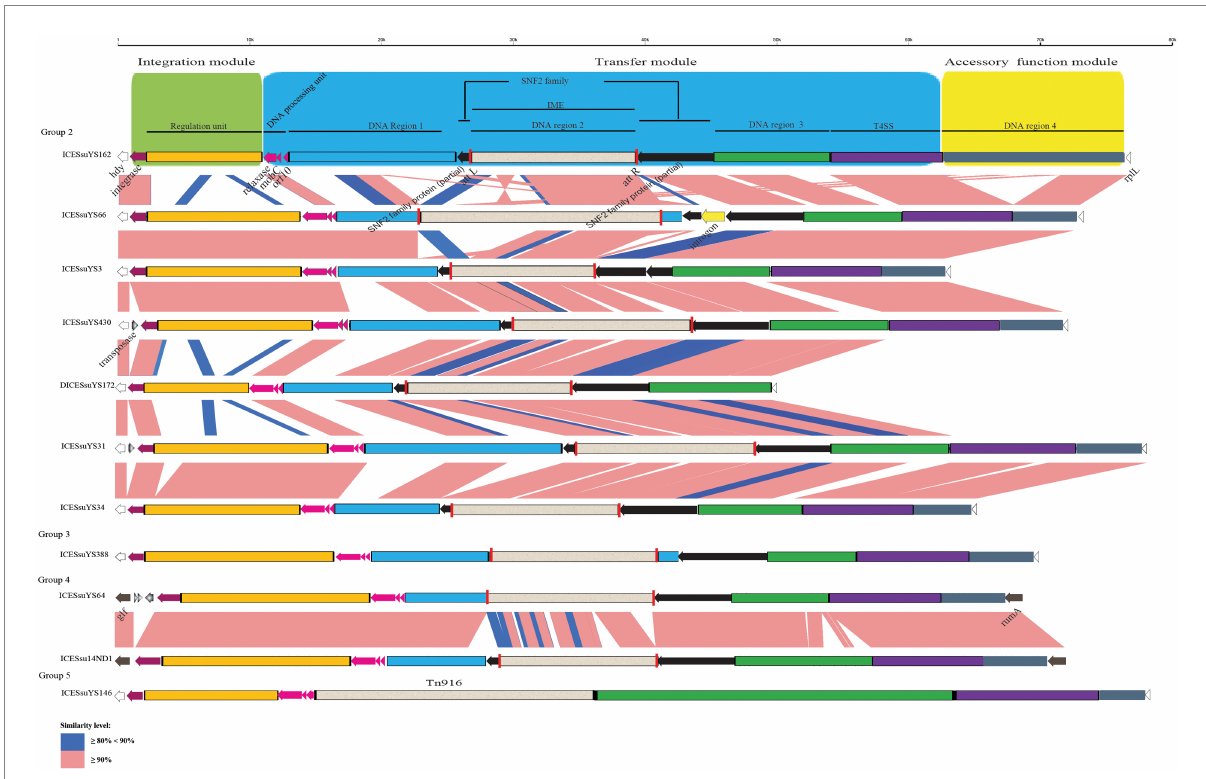
FIGURE 3 Schematic comparison of representative ICEs and DICEs carrying IMEs and transposon Tn 916 . The direction of the arrow indicates the direction of transcription. Regions of >90 and 80–90% identity are marked by pink and blue shading, respectively. The DNA regions, T4SS, IMEs, Tn 916 , integrase gene, relaxase gene, mobC , orf10 , snf2 gene, att site, integration module, transfer module, and accessory module of ICEs and DICEs are indicated by different colors. The rplL and hdy genes or rumA and glf genes are located in the flanking region of the ICEs and